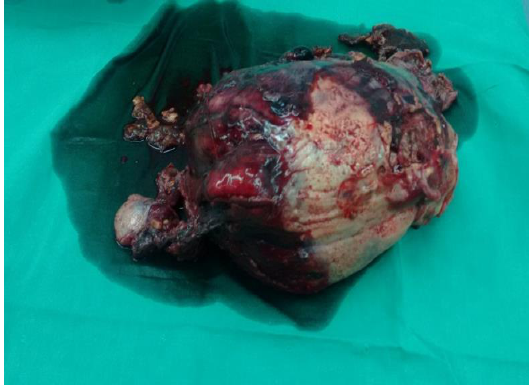
Figure 4. Gross excised specimen of benign lung metastasis obtained after left hemithoracotomy